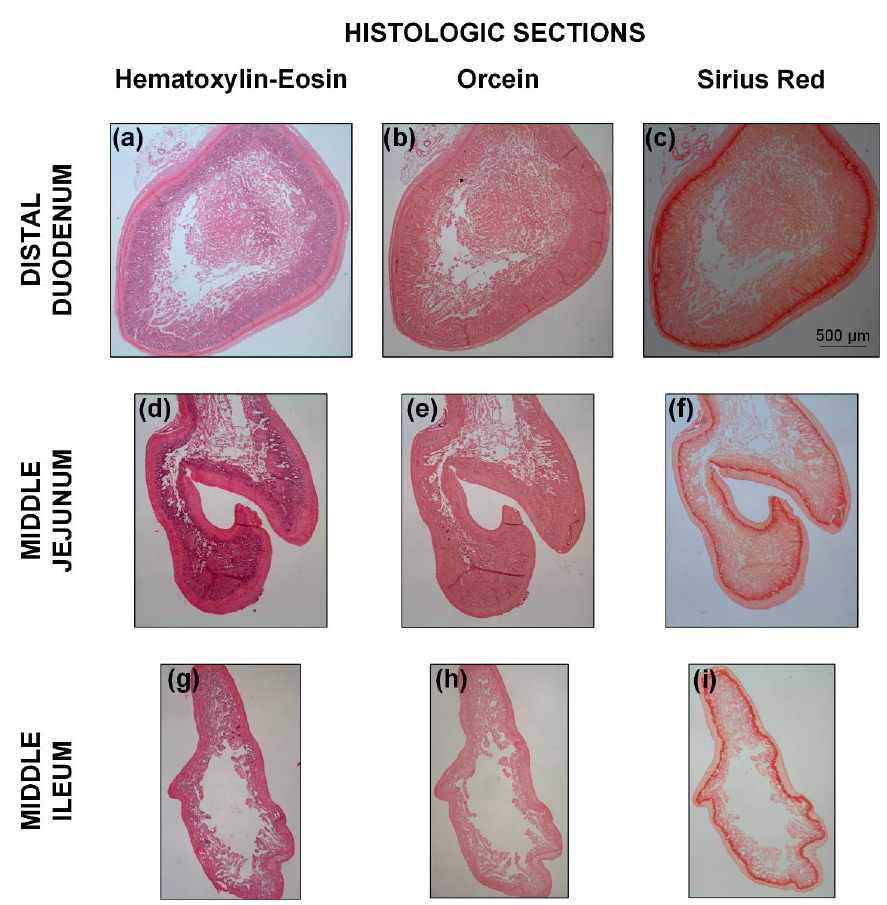
Figure 9. Representative adjacent transverse histologic sections for the ( a – c ) distal duodenum, ( d – f ) middle jejunum, and ( g – i ) middle ileum, stained with hematoxylin-eosin, orcein, and Sirius red for the identification of cells, elastin, and collagen, respectively. The scale bar applies to all the images.